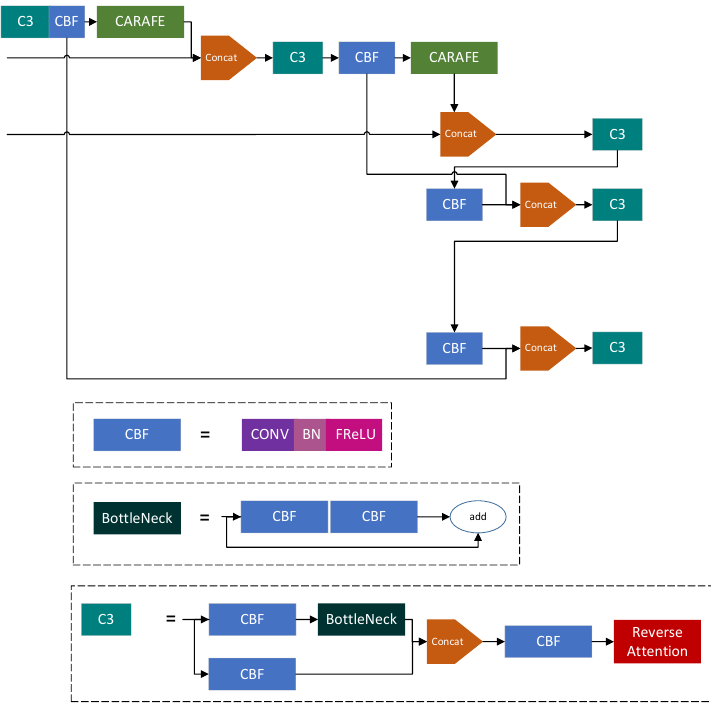
Figure 10. New neck structure. BCE with logits loss function check is designed before output. The overall structure of the Improved YOLOv5 network is shown in Figure 11.